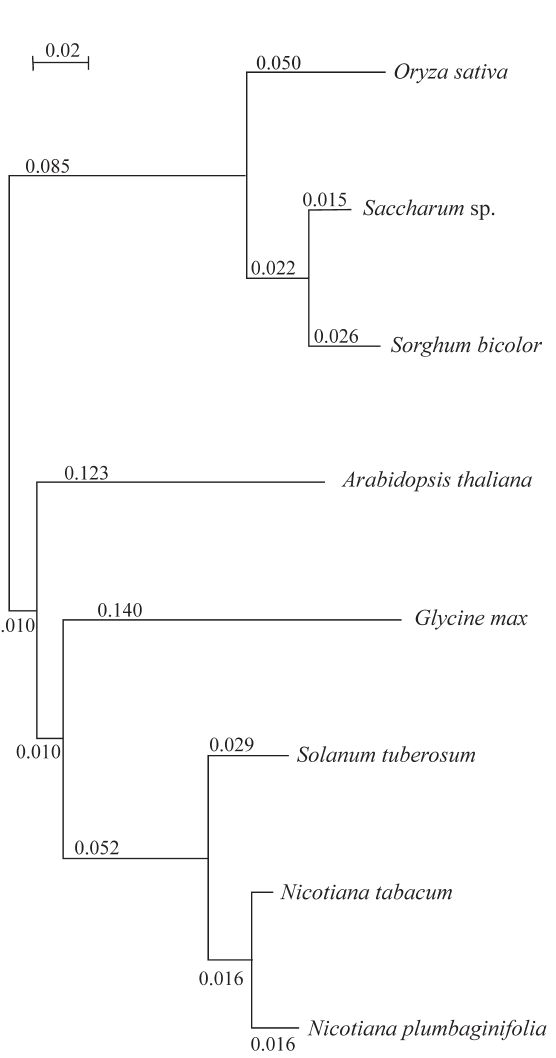
Figure 2 - Partial phylogenetic comparisons between the PHYB sequence from Saccharum sp and complete PHYB sequences available for other